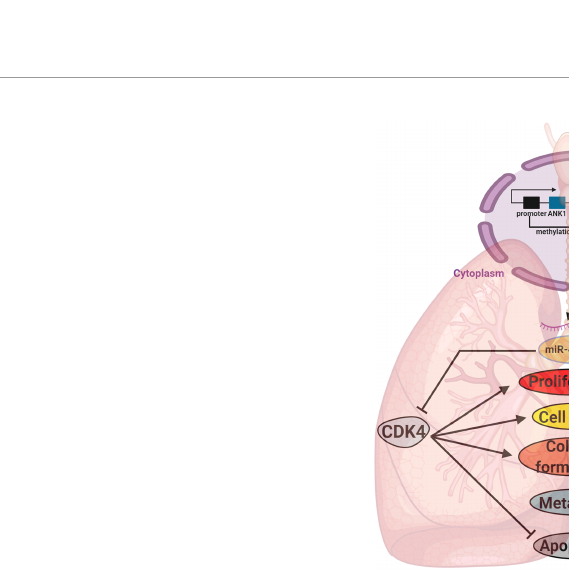
FIGURE 7 | A diagram of the biogenesis and function of miR-486-5p in NSCLC. Locating downstream of ANK1 , the biogenesis of miR-486-5p is often inhibited by hypermethylation of its promoter. By targeting CDK4, RSK, p70S6K and other genes, miR-486-5p can inhibit NSCLC by hindering cell proliferation and metastasis and promoting cell